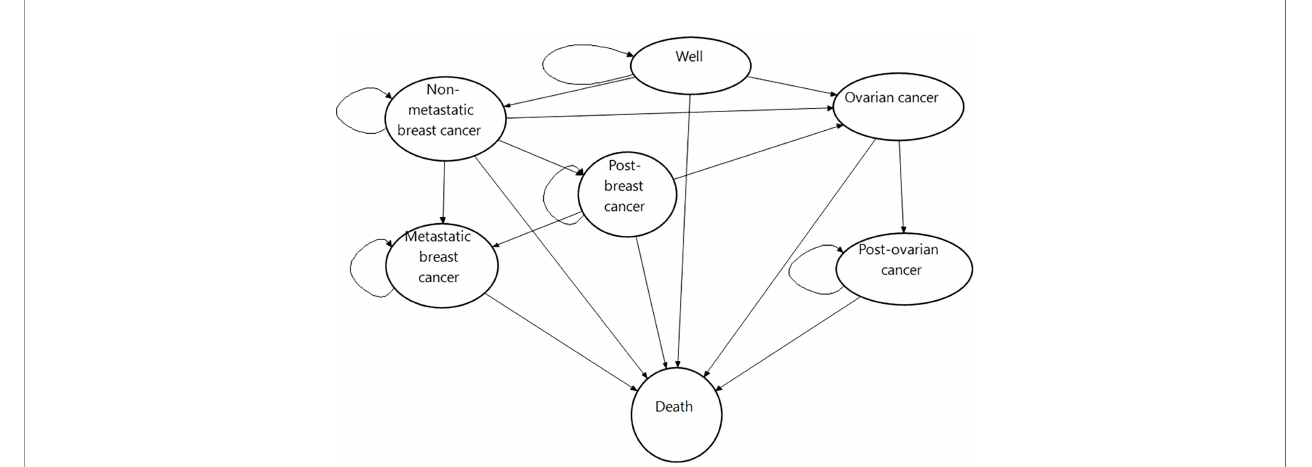
FIGURE 2 | Markov diagram.